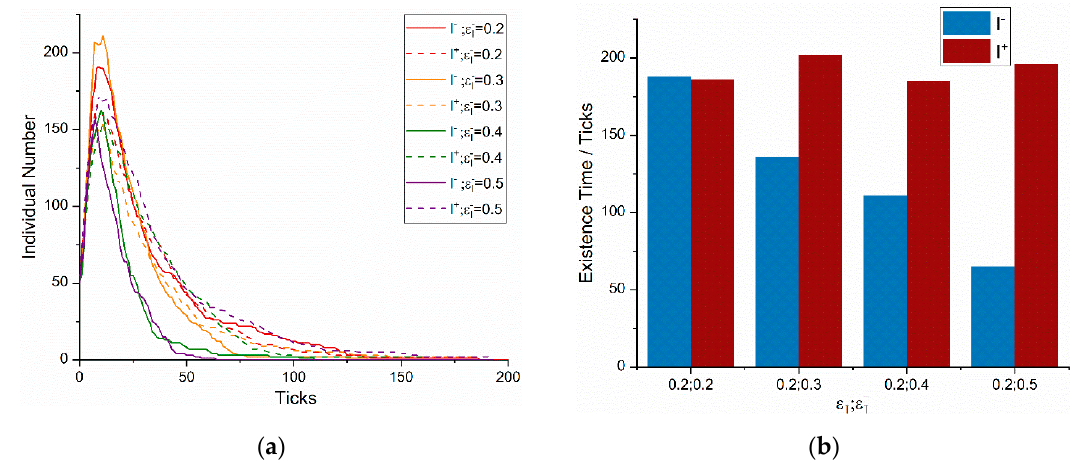
Figure 8. Brand OWOM communication effect when the brand protesters’ recessionary conditions are different. ( a ) The individual number of brand advocators and protesters; ( b ) the existence time of positive and negative OWOM.